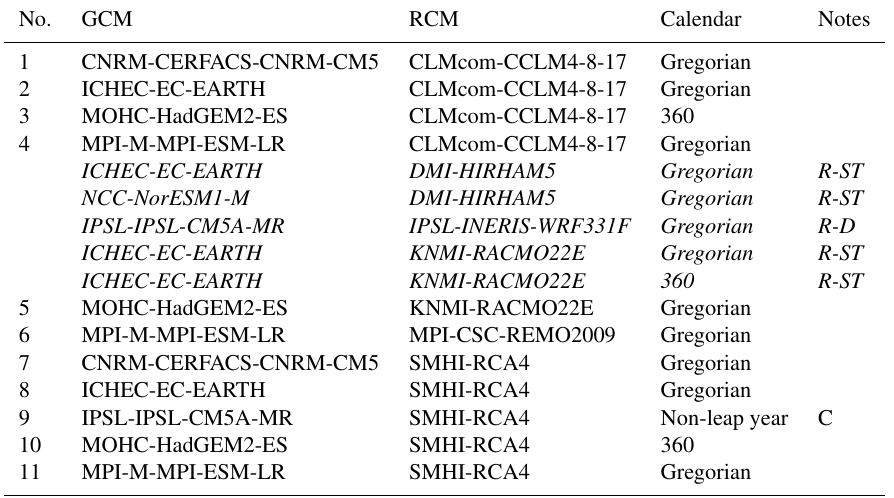
Table 3. Overview of the 11 EURO-CORDEX GCM-RCM combinations used in this study. Some models were removed from the ensemble due to either snow tower issues or irregularities in the discharge simulations. The models that were removed are denoted using italic font. No. GCM